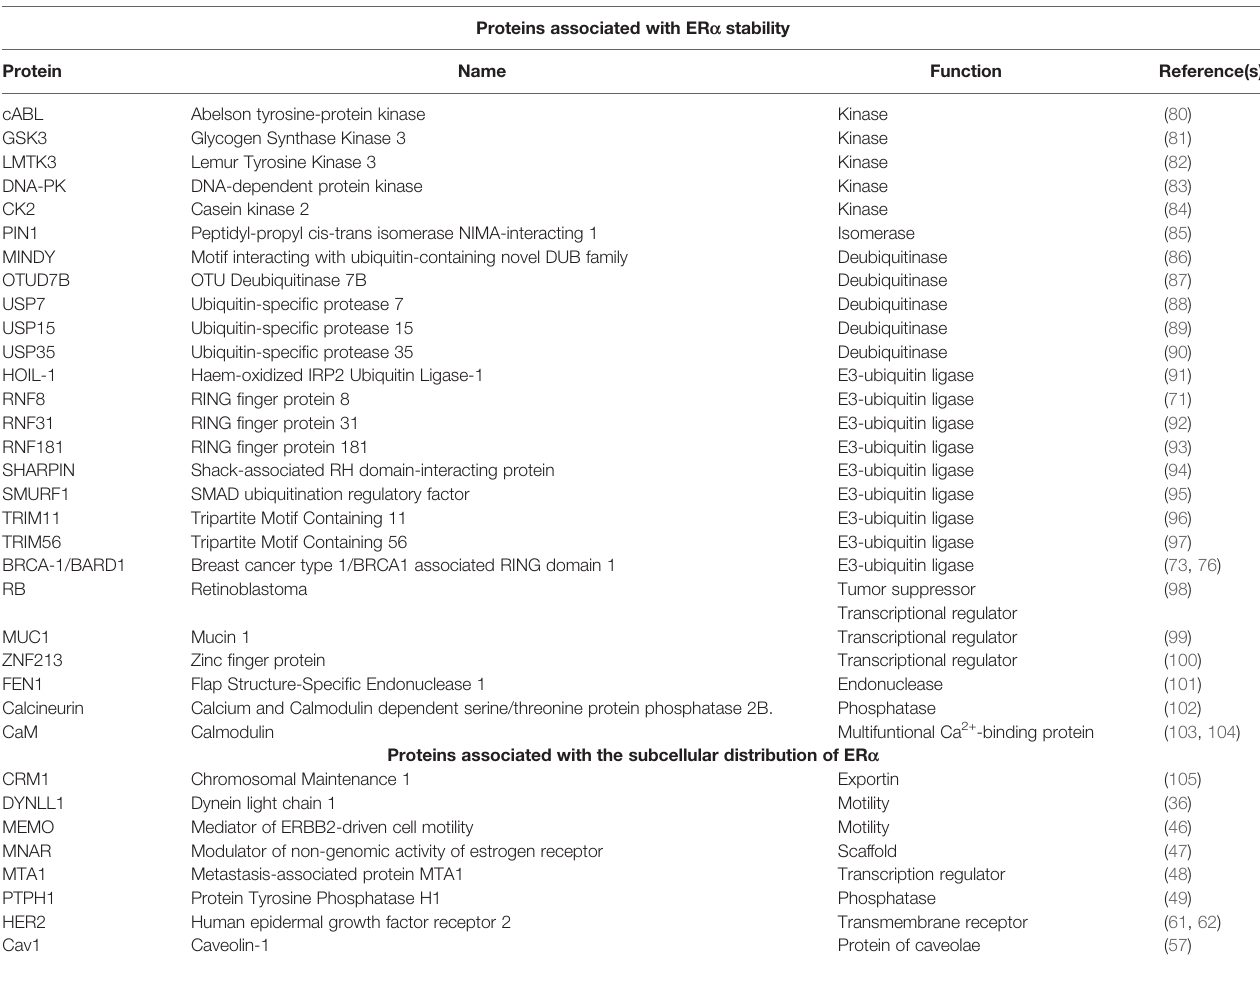
TABLE 1 | Principal proteins involved in the ER a stability and subcellular transport in breast cancer cells. Proteins associated with ER a